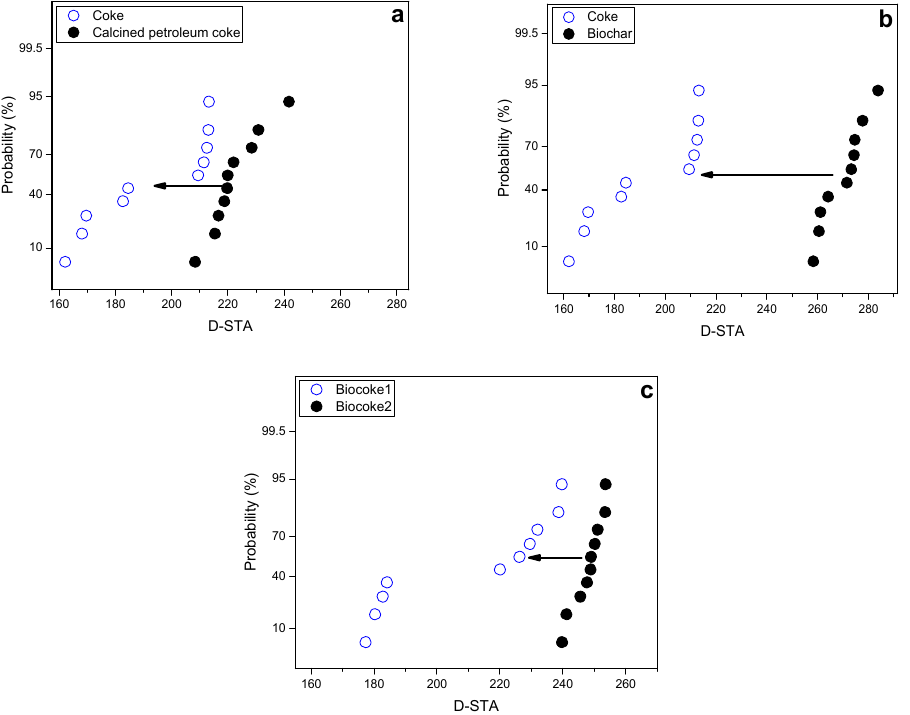
Figure 7. ( a ) Probability distribution of the D-STA parameter of coke and calcined petroleum coke; ( b ) coke and biochar; and ( c ) biocoke samples. The arrow indicates a statistically signi fi cant di ff er- ence.